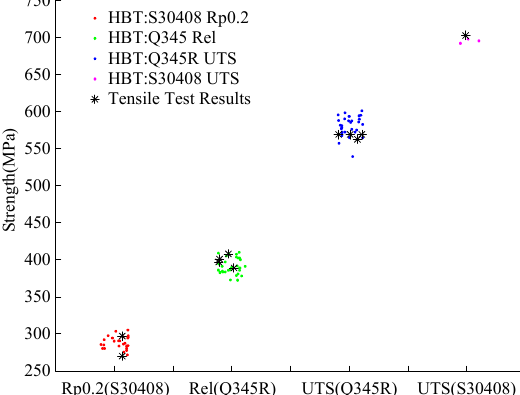
Figure 12. Comparing the results from HBT with conventional tensile test.